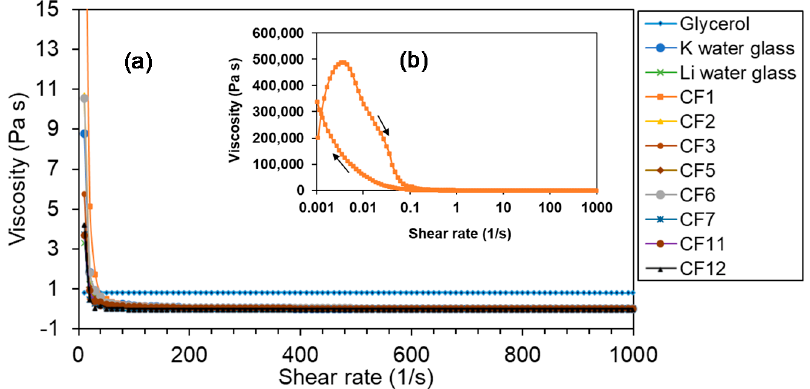
Figure 3. ( a ) Viscosity as a function of shear rate for selected formulations and ( b ) a typical flow behavior at lower shear rates (CF1).